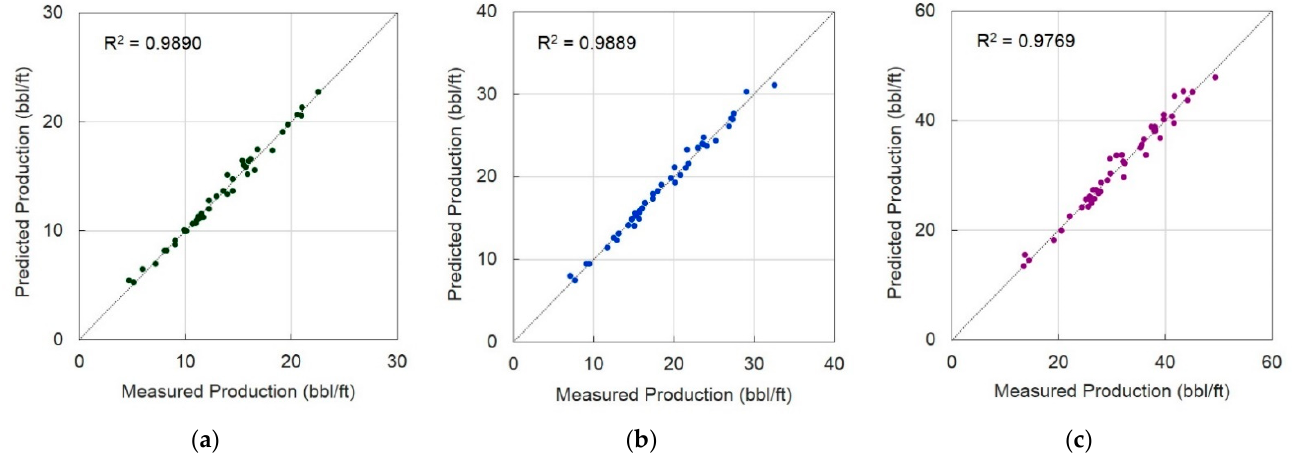
Figure 23. Comparison of the measured and predicted production for the testing wells: ( a ) NP 6; ( b ) NP 12; ( c ) NP 24.